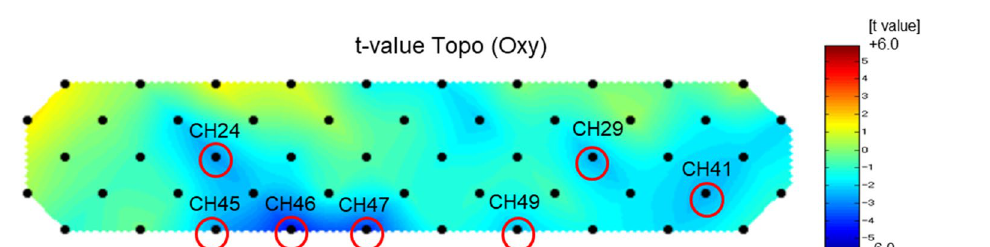
Figure 2. Topographic map of the differences in mean oxy-Hb concentration changes between the atrial fibrillation (AF) patients (n = 32) and control subjects (n = 29). The mean oxy-Hb concentrations in the right temporal lobe (channels 24 and 45), left temporal lobe (channels 29 and 41) and frontal region (channels 45–47 and 49) were significantly lower in the AF patients than in the control subjects (red circle, P <